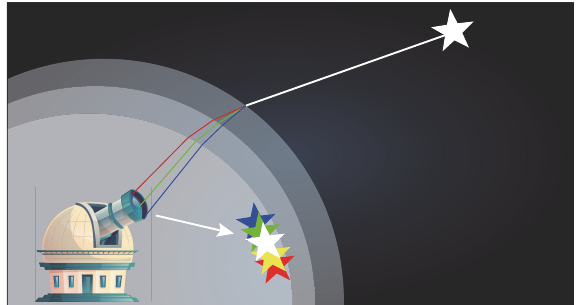
Figure 1: Sketch for atmospheric